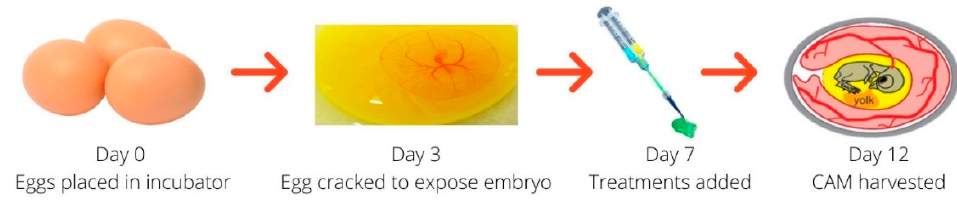
Figure 1. Experimental outline for the chick chorioallantoic membrane (CAM) experiment. Table 1. Formulations tested in the chick chorioallantoic membrane study and the amounts of star-polyglutamic acid (PGA) or vascular endothelial growth factor (VEGF) per 200 µL gel portion for each. Free VEGF refers to the VEGF in the HA-TA hydrogel that is not encapsulated in a nano- particle.